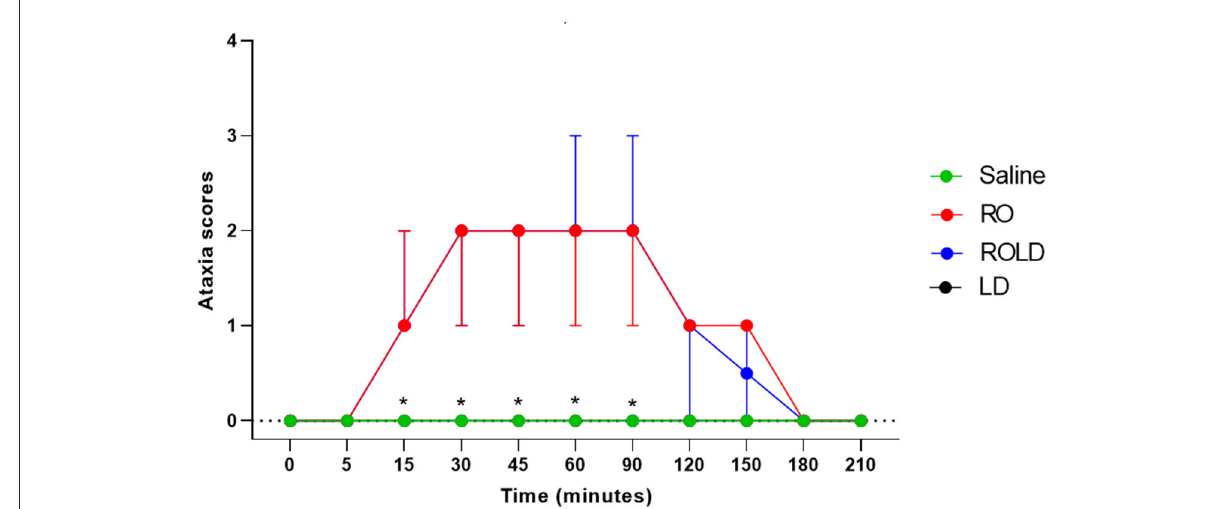
FIGURE6 Ataxia scores (median and range) pre- epidural and post- epidural injection of saline ( n = 6), romifidine (RO) (50 µ g kg − 1) ( n = 6), romifidine-lidocaine (ROLD) (50 µ g and 0.30mg kg − 1) ( n = 6) and lidocaine (LD) (0.3 0mg kg − 1) ( n = 6) in donkeys. *: Saline and LD differ significantly from RO and ROLD combination.